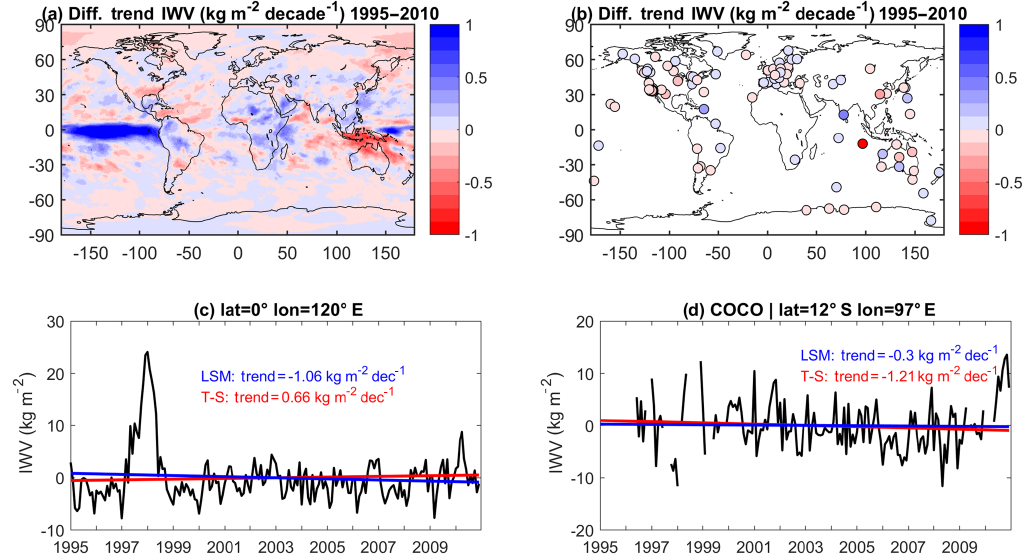
Figure A1. (a) Trend differences between two methods of computing trends (Theil–Sen minus the least squares method) for the ERA- Interim data used in the paper. The root mean square of the difference is 0.20kgm − 2 decade − 1 . (b) Same as panel (a) , but for the GPS data at 104 stations. The root mean square of the difference is 0.14kgm − 2 decade − 1 . (c) Time series of IWV anomaly in ERA-Interim at a point of large difference between methods in the tropical Pacific ocean with superposed linear trends. (d) Time series of IWV anomaly at the COCO GPS site with superposed linear